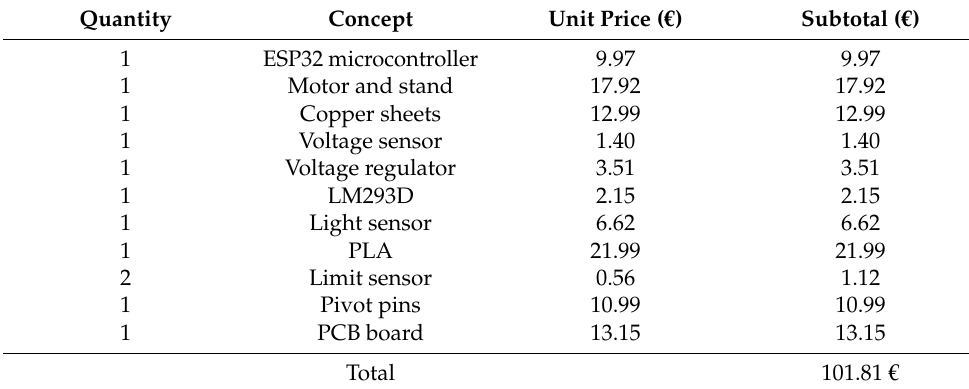
Table 3. Smart cover components